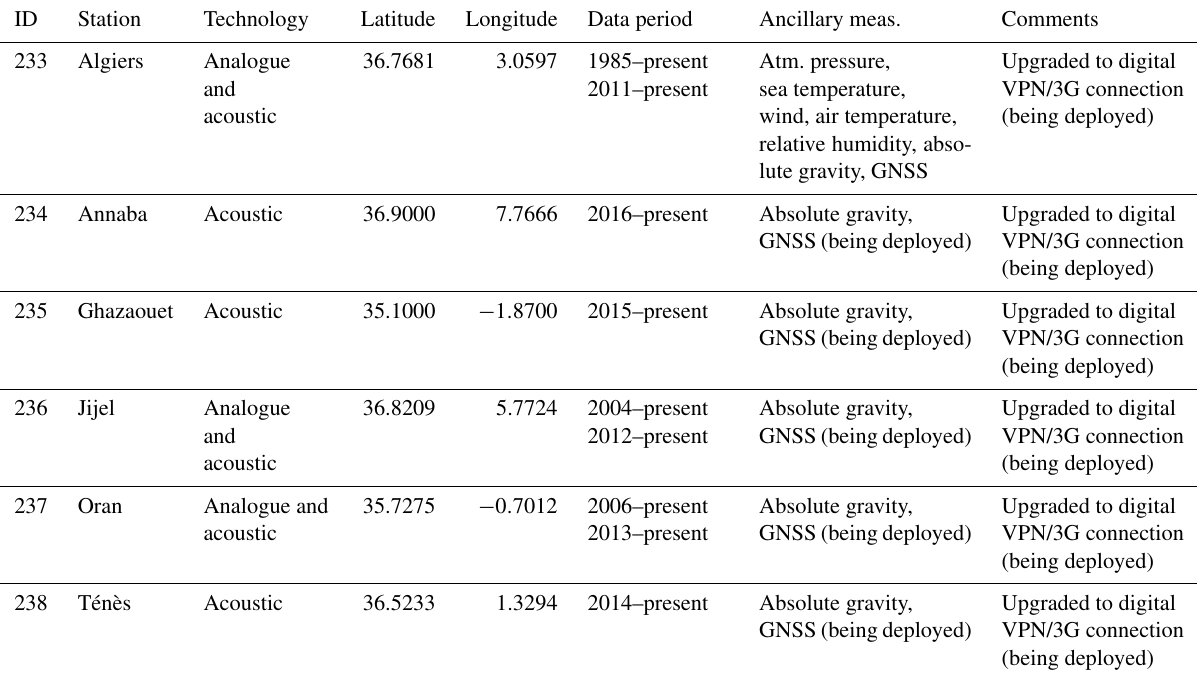
Table A26. Stations operated by Algeria (National Institute of Cartography and Remote Sensing).